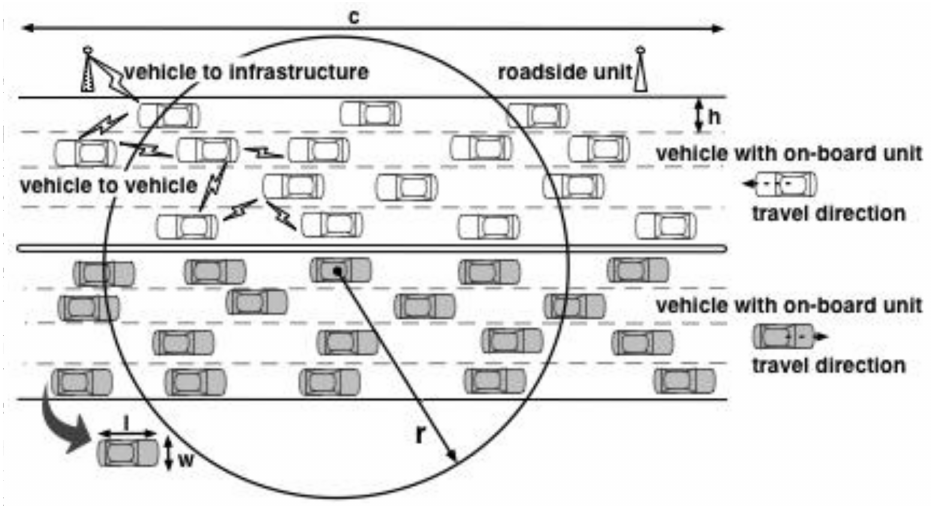
Figure 1. A typical road scenario with vehicular ad hoc network (VANET) system considered in this